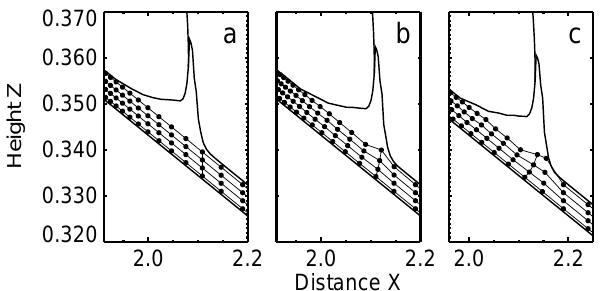
Fig. 6. Experiment B: Relatively soft and moderately non-linear till ( m =3 , B =0 . 35 ): Three snapshots (a–c) at intervals of two dimensionless time units T show the evolution of five internal sediment layers which are parallel at the time T =15 (a), when the sediment bulge had an almost stable slope. Sediment uplift takes place at the transition from the down-facing bulge slope to the undisturbed sediment layer (b–c). A vertical straight line in (a) is followed throughout (b–c).